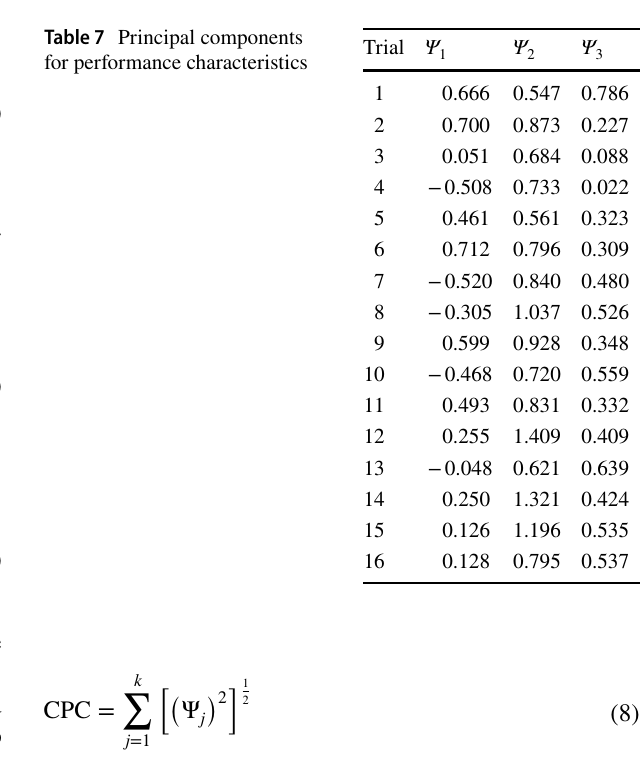
Principal components Ψ 1 surface roughness Ψ 2